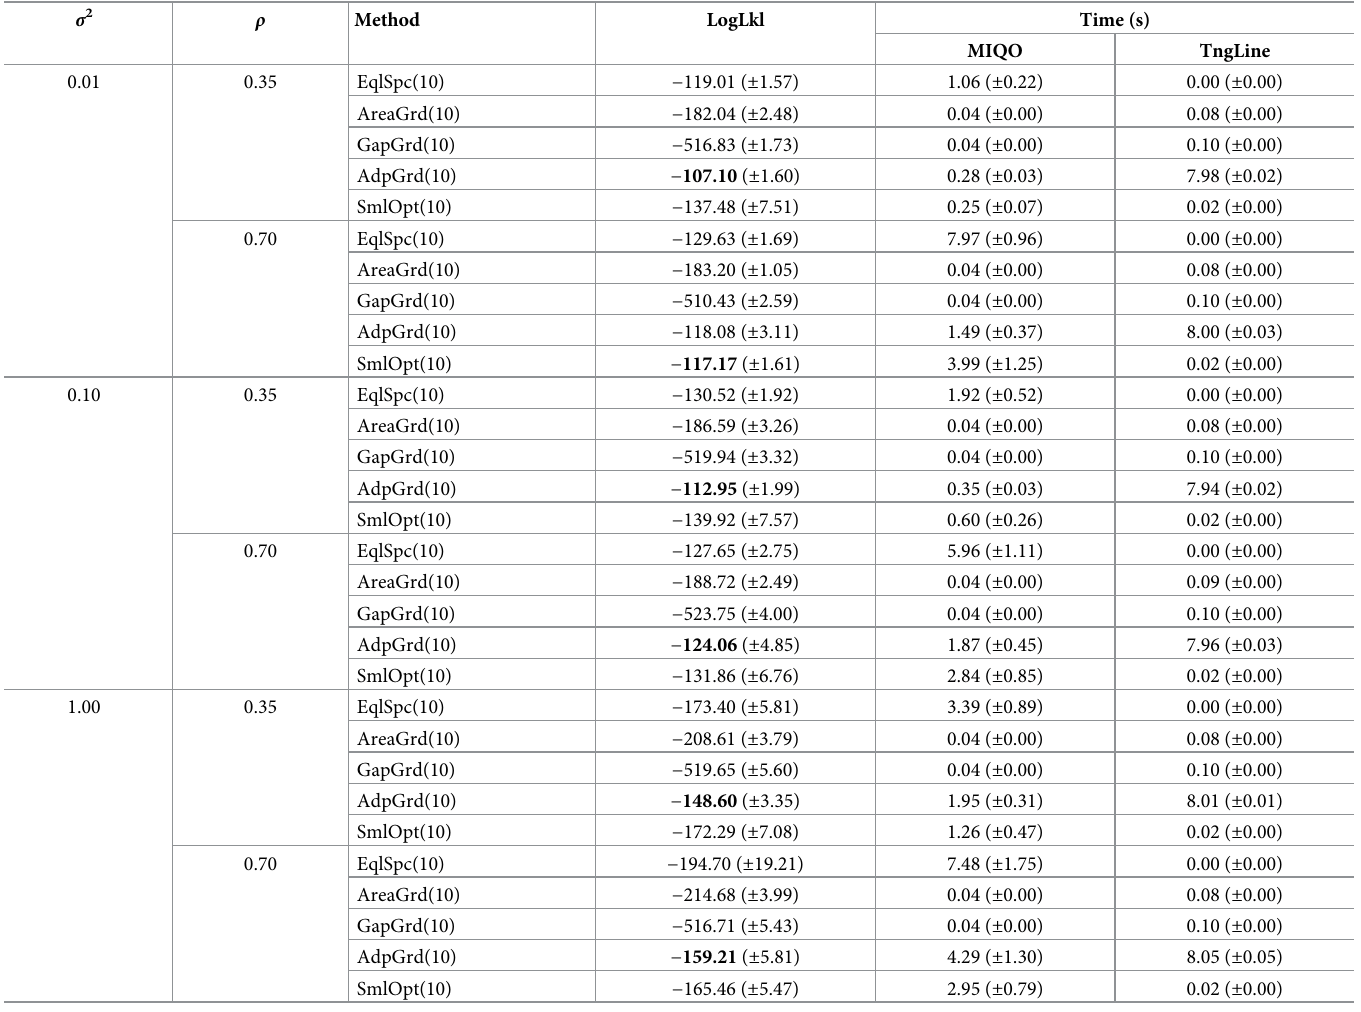
Table 1. Results of our MIQO formulation for synthetic training instances ( θ =